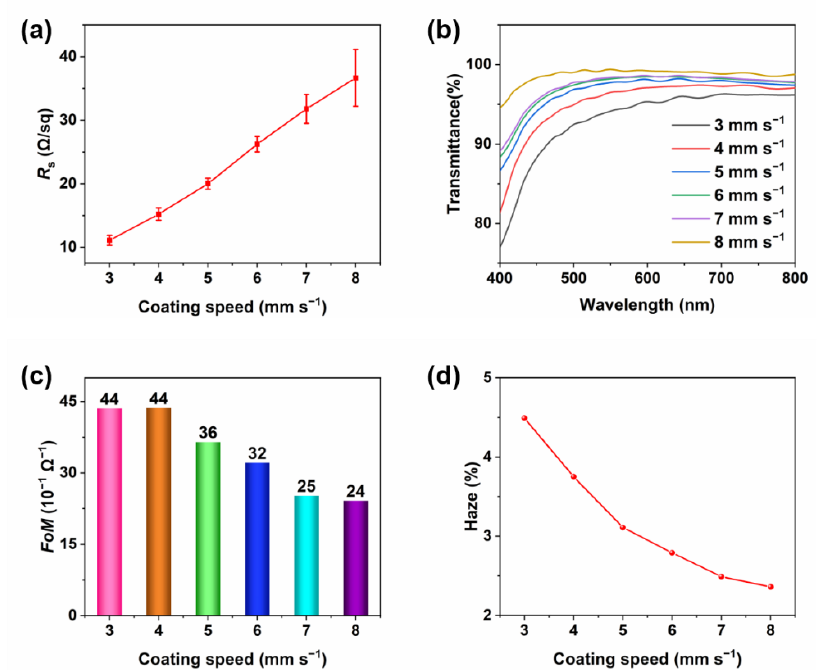
Figure 3. Optoelectronic properties of the AgNW film produced at different coating speeds: ( a ) the R s of the AgNW films; ( b ) the transmittance of the AgNW films from 400 nm to 800 nm; ( c ) the FoM ; ( d ) the haze values of the AgNW films.